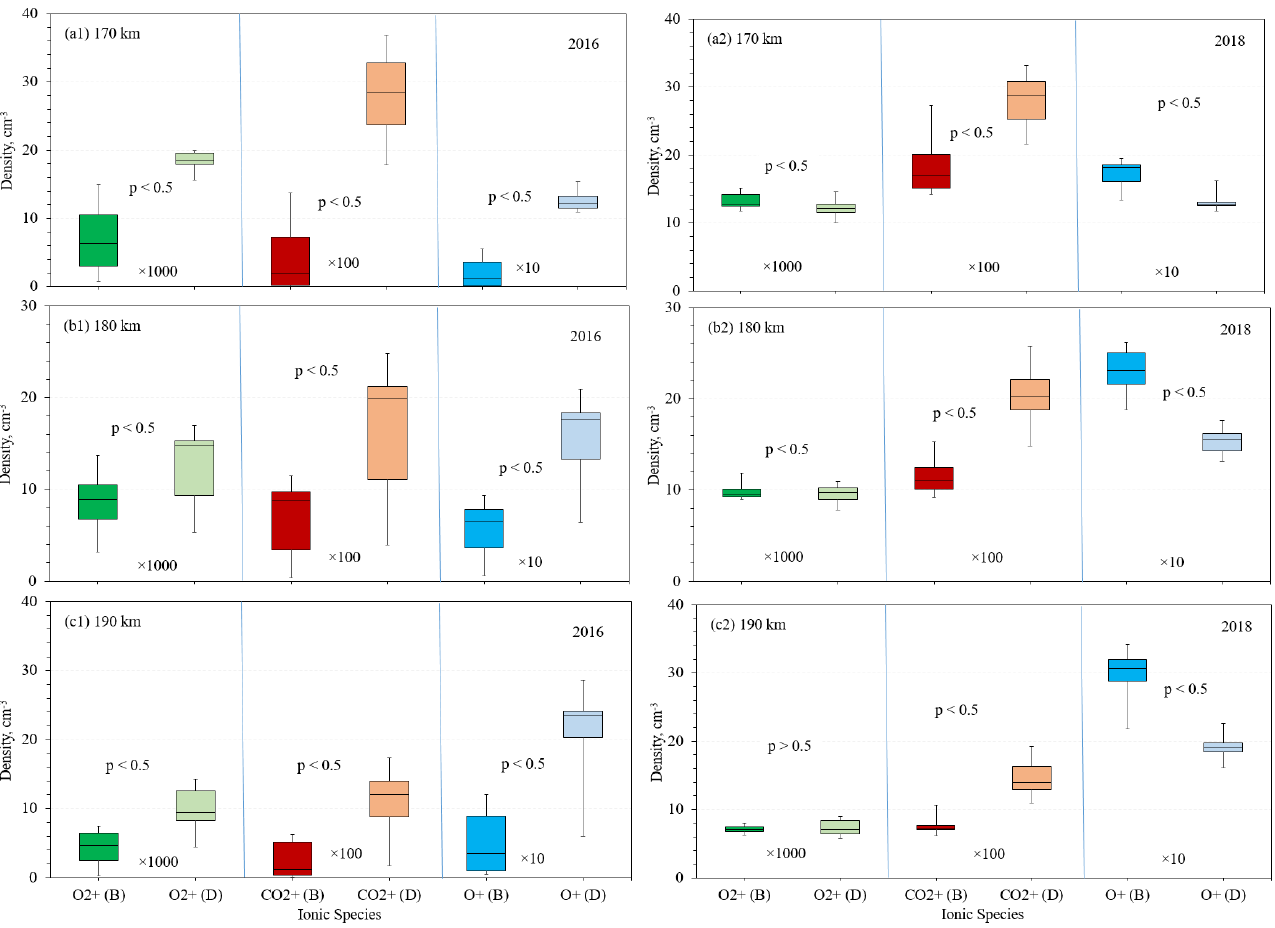
Figure 9. Box plots of variations of O 2+ , CO 2+ , and O + at ( a1 – c1 ) from 9 September–2 October 2016 (RDS 2016); ( a2 – c2 ) from 27 May to 17 June 2018 (GDS 2018). B: before the storm; and D: during the storm.